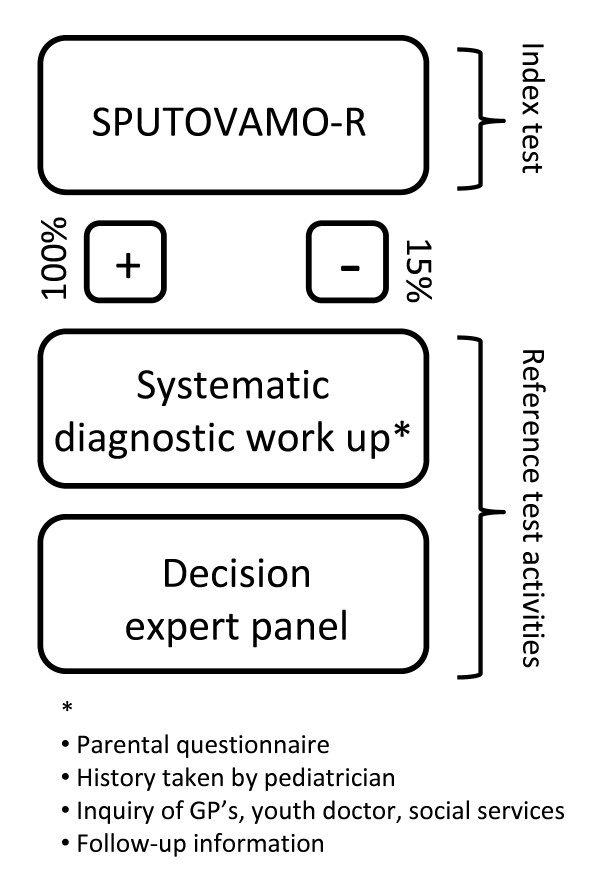
Design of CHAIN-ER.